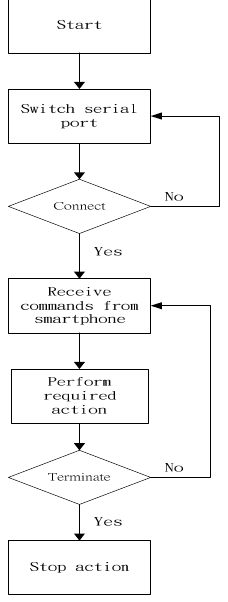
Figure 22. Sequence of WMR operation. Appl. Sci. 2016, 6, 82